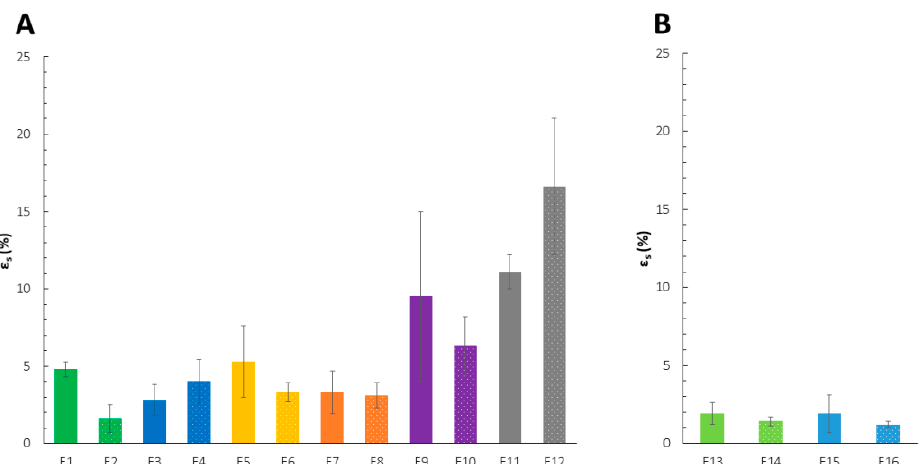
Figure 2. Mechanical properties of the films F1–F12 ( A ) and F13–F16 ( B ) expressed as elongation at break ( ε s ) (mean ± SD, n ≥ 3, p < 0.05). Formulations with the same polymer ratio and deposition order, but different LM PC type were indicated with the same color.